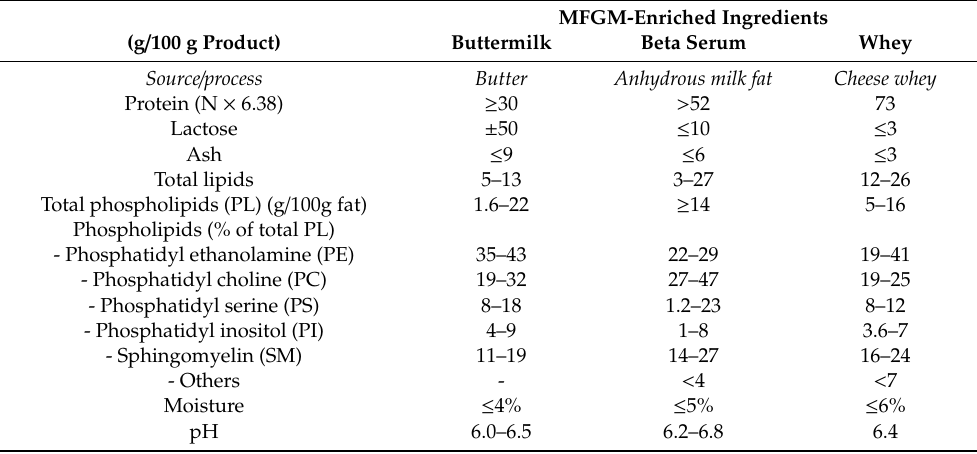
Table 1. Commercially available MFGM-enriched dairy